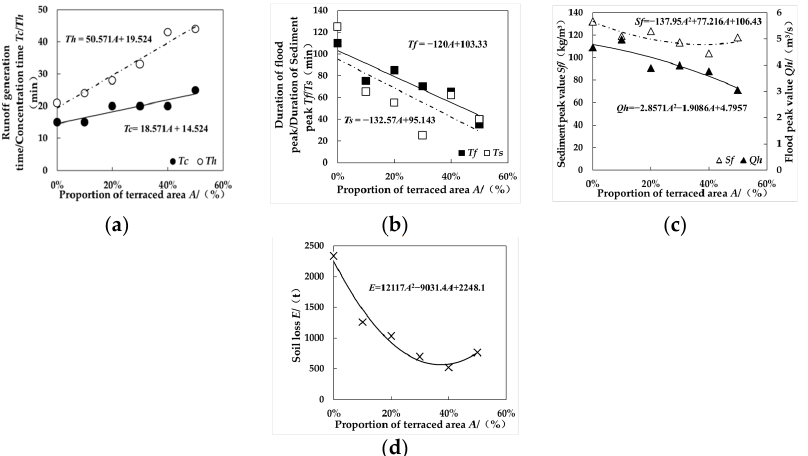
Figure 6. Variation law of watershed-erosion-transportation processes under the conditions of different terrace-laying areas ( x , y -axis). (( a ) A - T c /T h , ( b ) A - T f /T s , ( c ) A - Q h /S f , ( d ) A - E ).